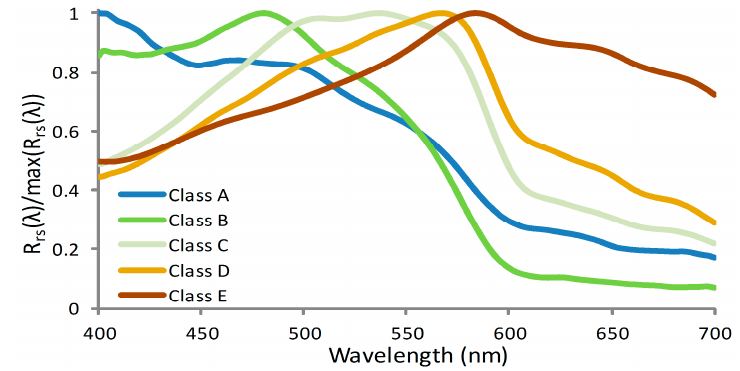
Figure 5. The six cruises’ average spectral shapes ( R rs ( λ )/max( R rs ( λ ))) for the five